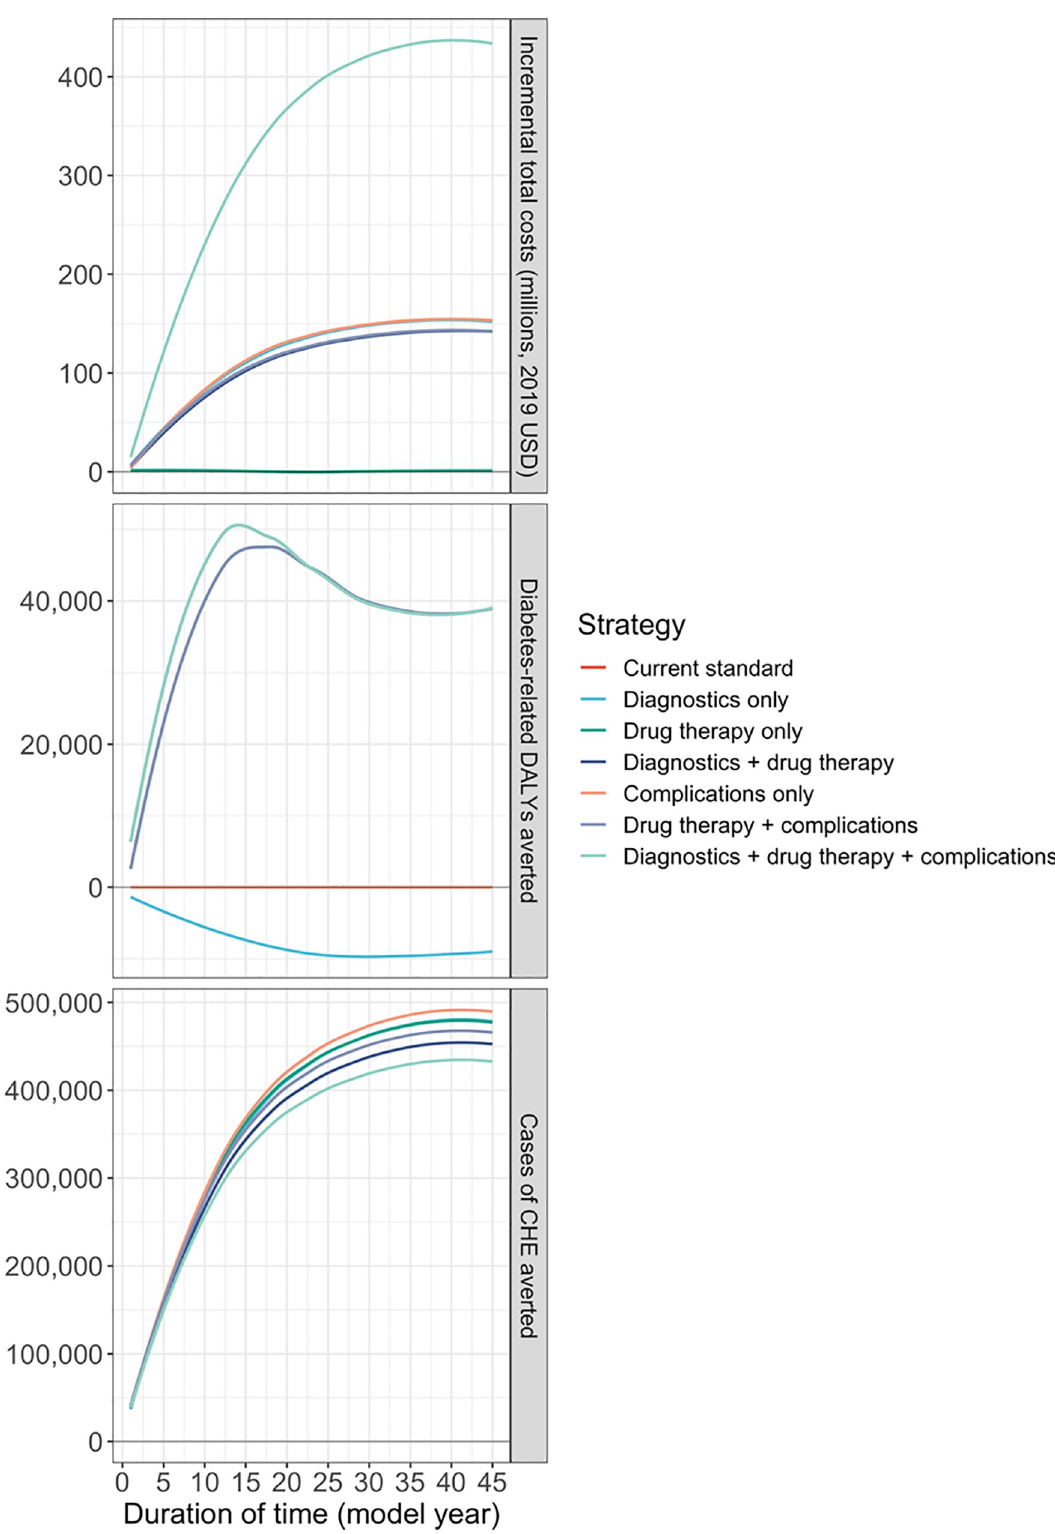
Fig 3. Incremental costs and impacts over time, HEF eligibility 20%, OOP coverage 100%.